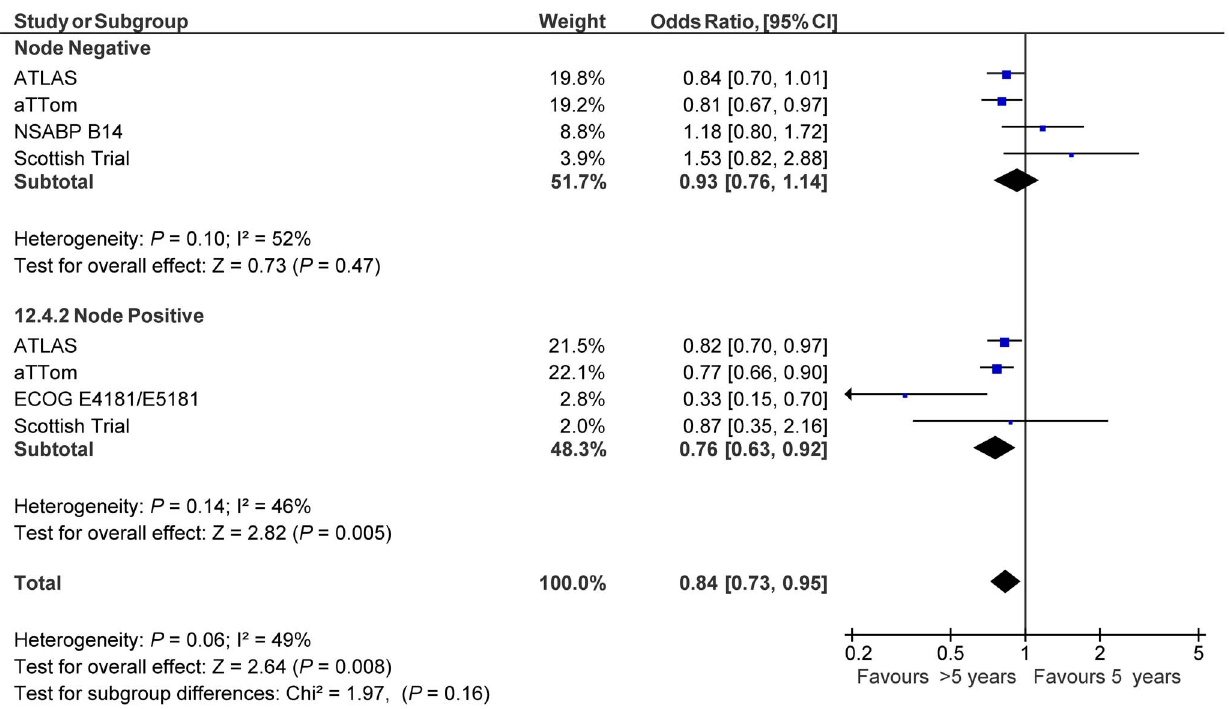
Figure 4. Forest plots of odds ratios for breast cancer recurrence in node negative and in node positive patients with extended adjuvant tamoxifen ( . 5 years) versus adjuvant tamoxifen (5 years) based on primary analysis of individual trials. Odds ratios for each trial are represented by the squares , the size of the square represents the weight of the trial in the meta-analysis, and the horizontal line crossing the square represents the 95% confidence interval. The diamonds represent the estimated pooled effect based for each cohort individually (labeled subtotal) and for all cohorts together (labeled total).